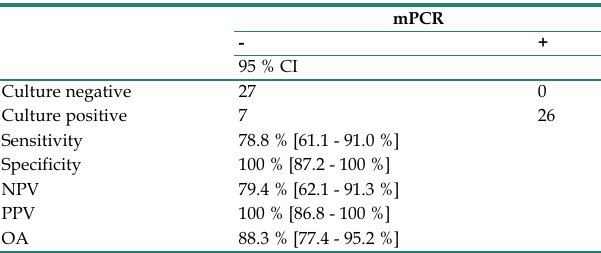
Table 3. Overview of the statistical evaluation of the entire study group. [mPCR = Multiplex Poymerase Chain Reaction, - = negative mPCR result, + = positive mPCR result, CI = Confidence Interval, NPV = negative predictive value, PPV = positive predictive value, OA = overall accuracy] mPCR - + 95 %